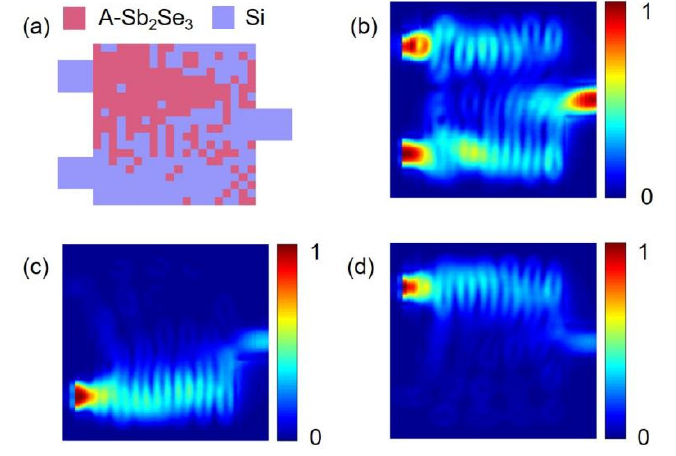
Figure 5. Energy density distribution of the AND gate when Sb 2 Se 3 is in the amorphous state. ( a ) The final structure of our device; the red pixels are Sb 2 Se 3 in the amorphous state and the purple pixels are silicon; ( b ) Energy distribution when the input state is ‘11’; ( c ) Input state is ‘01’; ( d ) Input state is ‘10’.